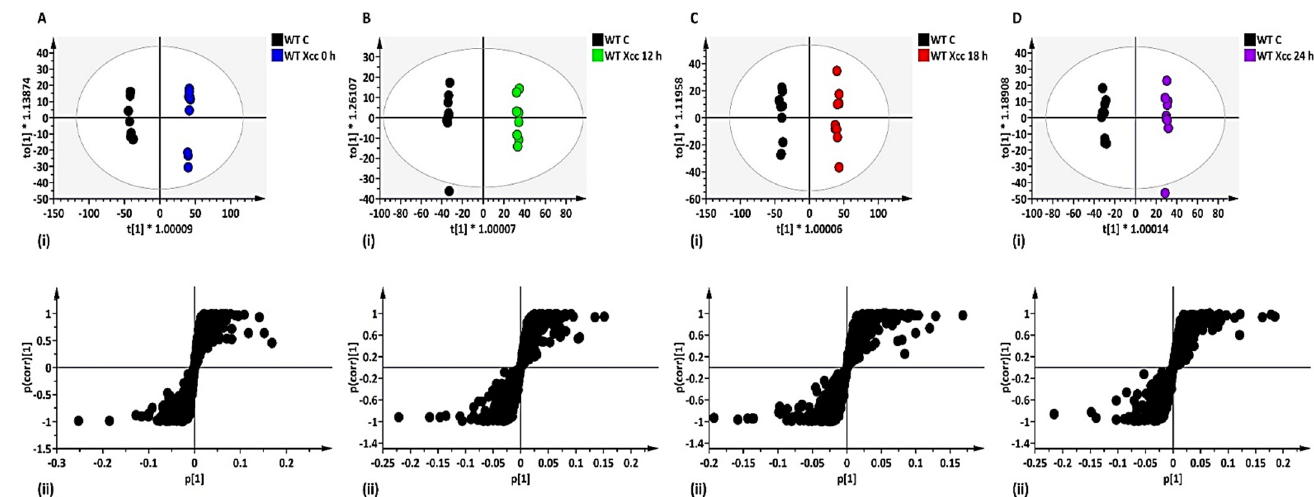
Figure 2. OPLS-DA modelling of Arabidopsis WT leaf extracts, (ESI ( − ) data). ( A – D ) ( i ) represent OPLS-DA score plots showing clear separation between control vs. LPS Xcc treatment after 0, 12, 18, and 24 h, respectively. ( A – D ) ( ii ) represent OPLS-DA loading S-plots showing the discriminant fea- tures (ions) responsible for the sample grouping observed in ( A – D ) ( i ). The OPLS-DA model parame- ters were: ( A ) R 2 X = 57.8%/Q 2 = 99.3%, ( B ) R 2 X = 48.9%/Q 2 = 99.0%, ( C ) R 2 X = 64.0%/Q 2 = 99.3%, ( D ) R 2 X = 45.5%/Q 2 = 98.5%, respectively. The variables in the top right quadrants of the S-plots correlated positively to the treatment. Selected discriminant ions for downstream metabolite identifi- cations were based on a correlation [ p (corr)] of ≥ 0.5 and covariance of (p1) ≥ 0.05. The equivalent set of figures for the ESI (+) mode is presented as Figure